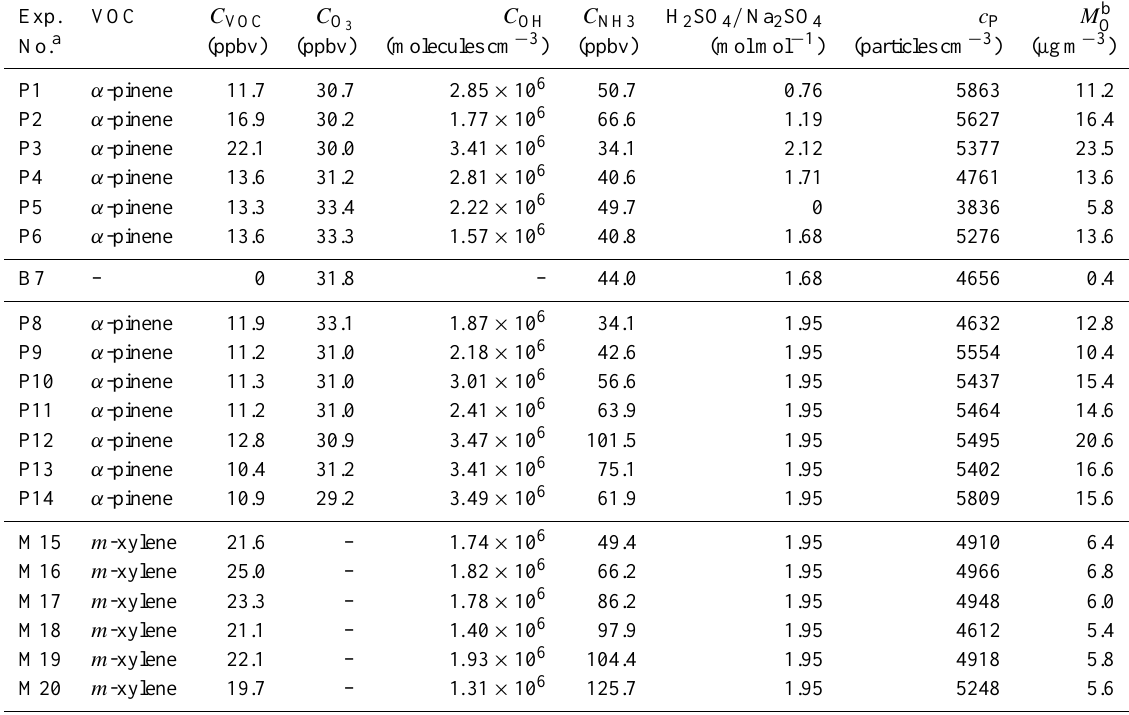
Table 1. Initial gaseous and particle phase experimental conditions.